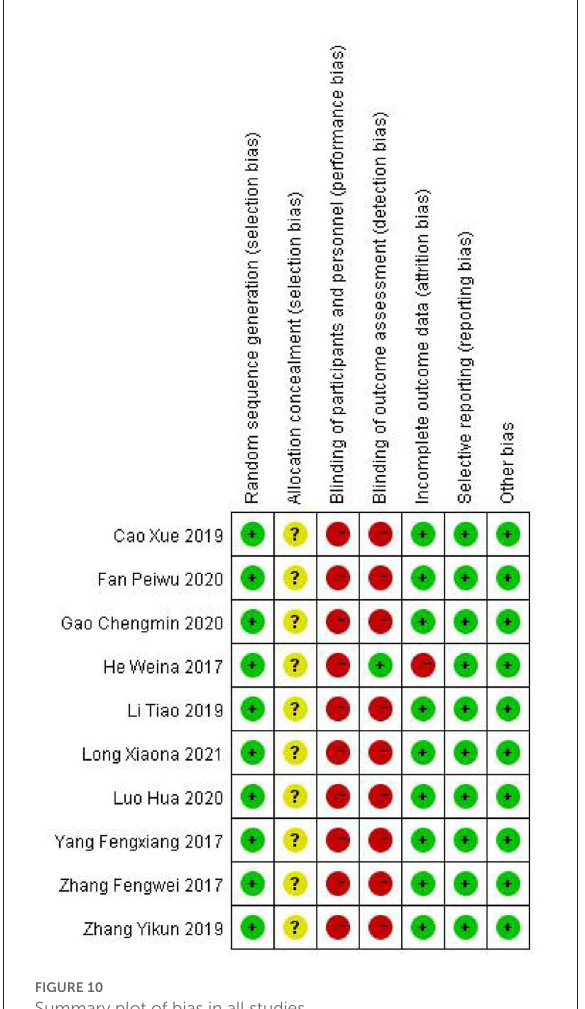
FIGURE10 Summary plot of bias in all